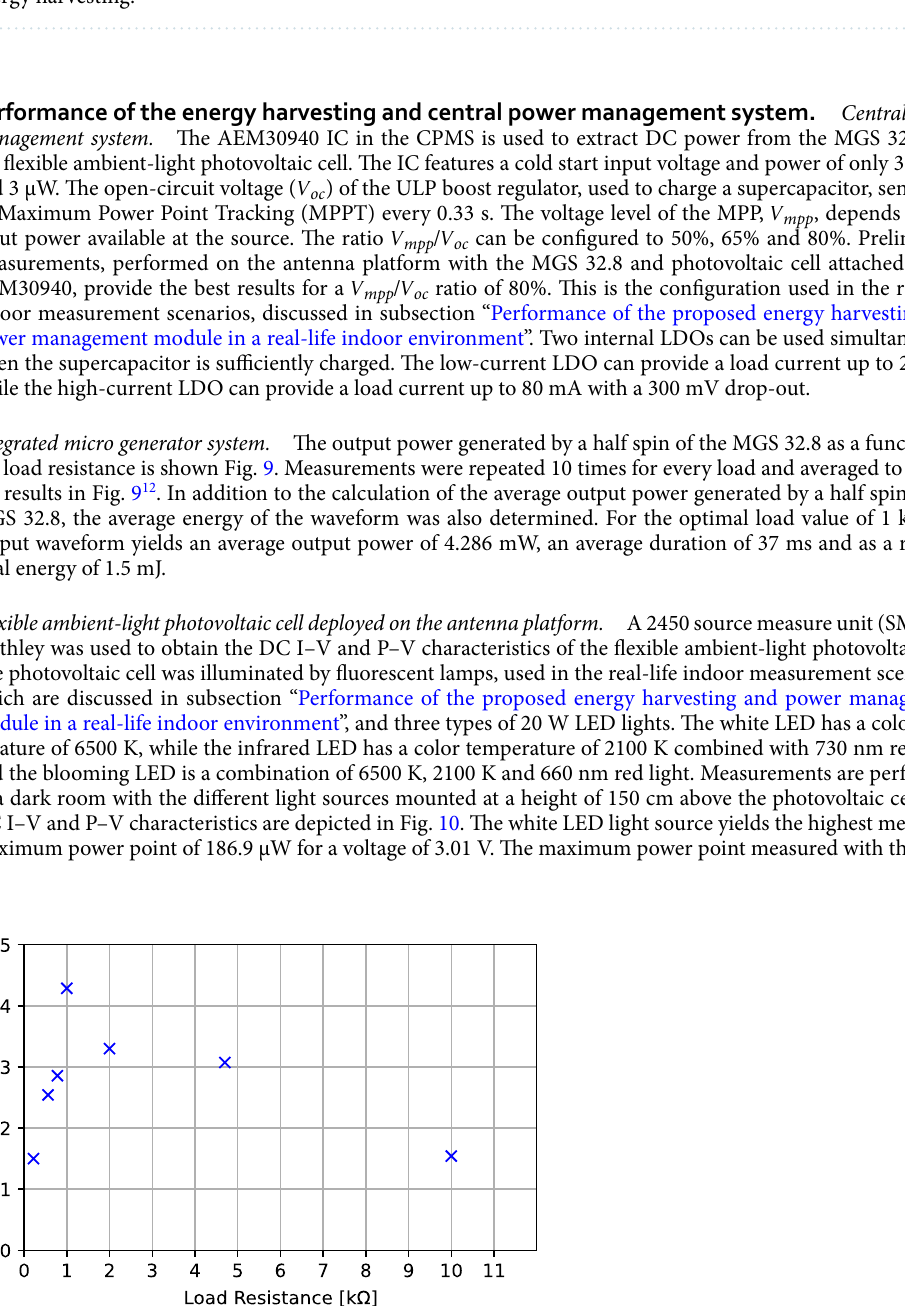
Table 2. Comparison of the proposed antenna platform with other reported antenna platforms suitable for energy harvesting.